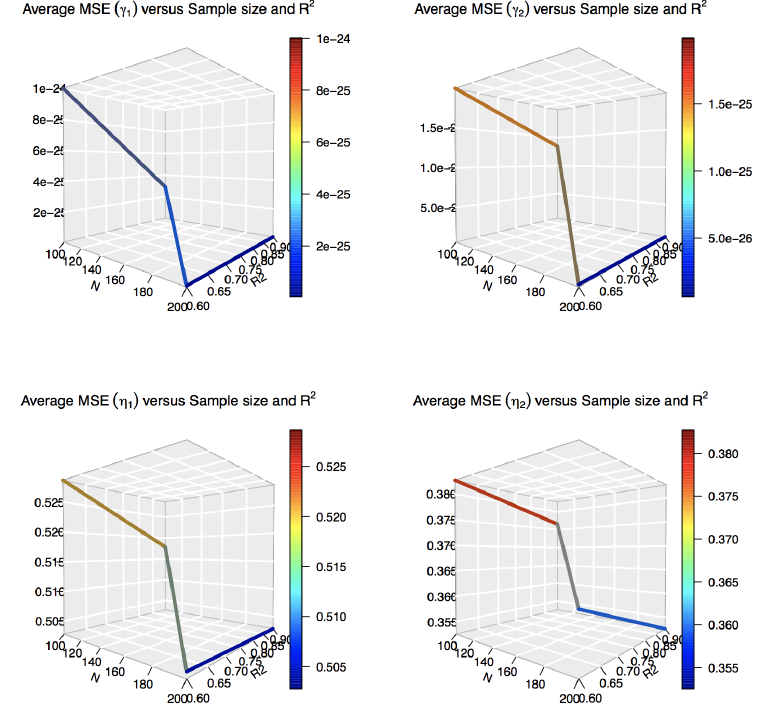
Figure 1. Average MSE of functional coefficients versus simulation cases (3-D